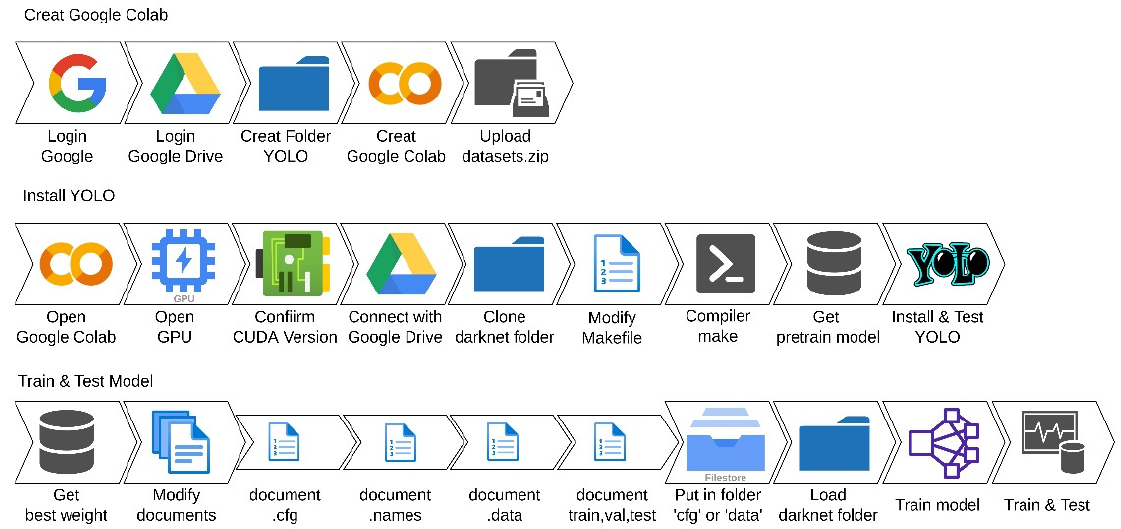
Figure 3. Implementation of YOLOv1~YOLOv4 for model training and testing with Google Colab.